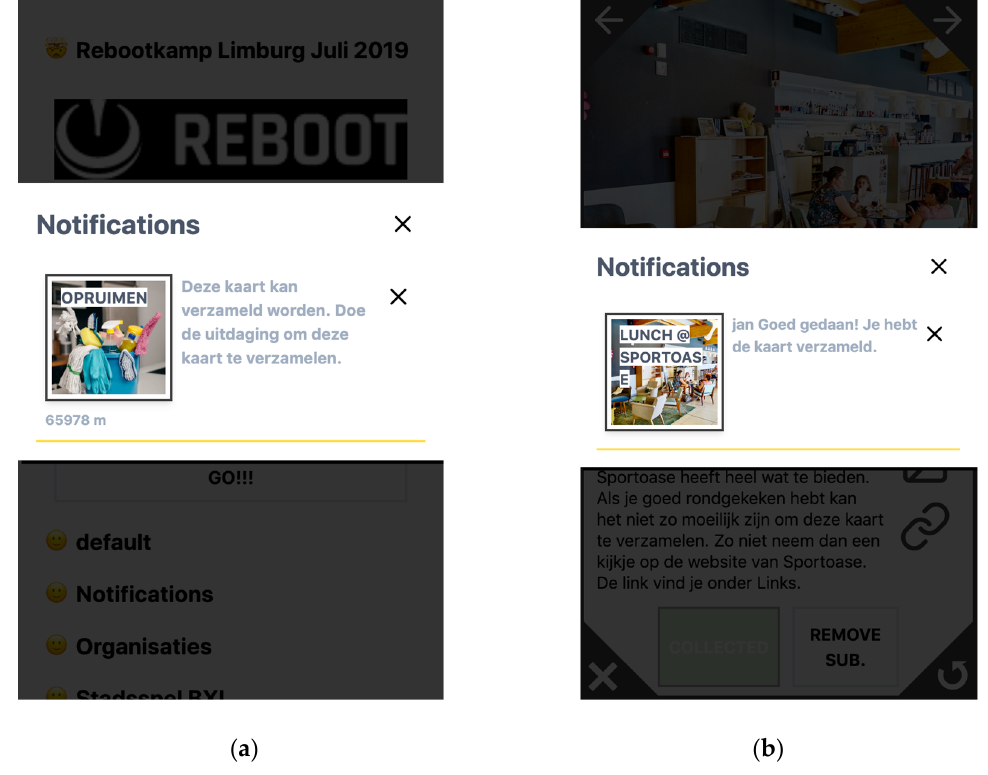
Figure 5. (a) An example of an internal notification—clicking on the image will allow the user to jump to the card directly; (b) Example feedback message in case of a successfully performed challenge.